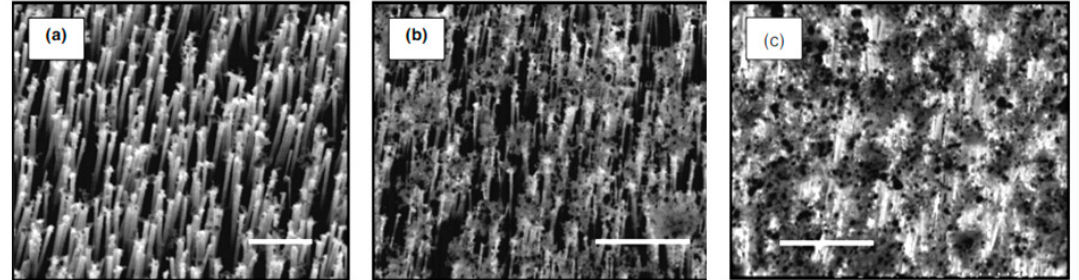
Figure 28. SEM images of Au nanoparticles attached to the tips of the nanowire assembly at different stages of the deposition: ( a ) 10 min; ( b ) 1 h; ( c ) 2 h. Scale bars = 1 µ m. Reproduced with permission from Parthangal et al. [309]. Copyright 2007: Cambridge University Press.